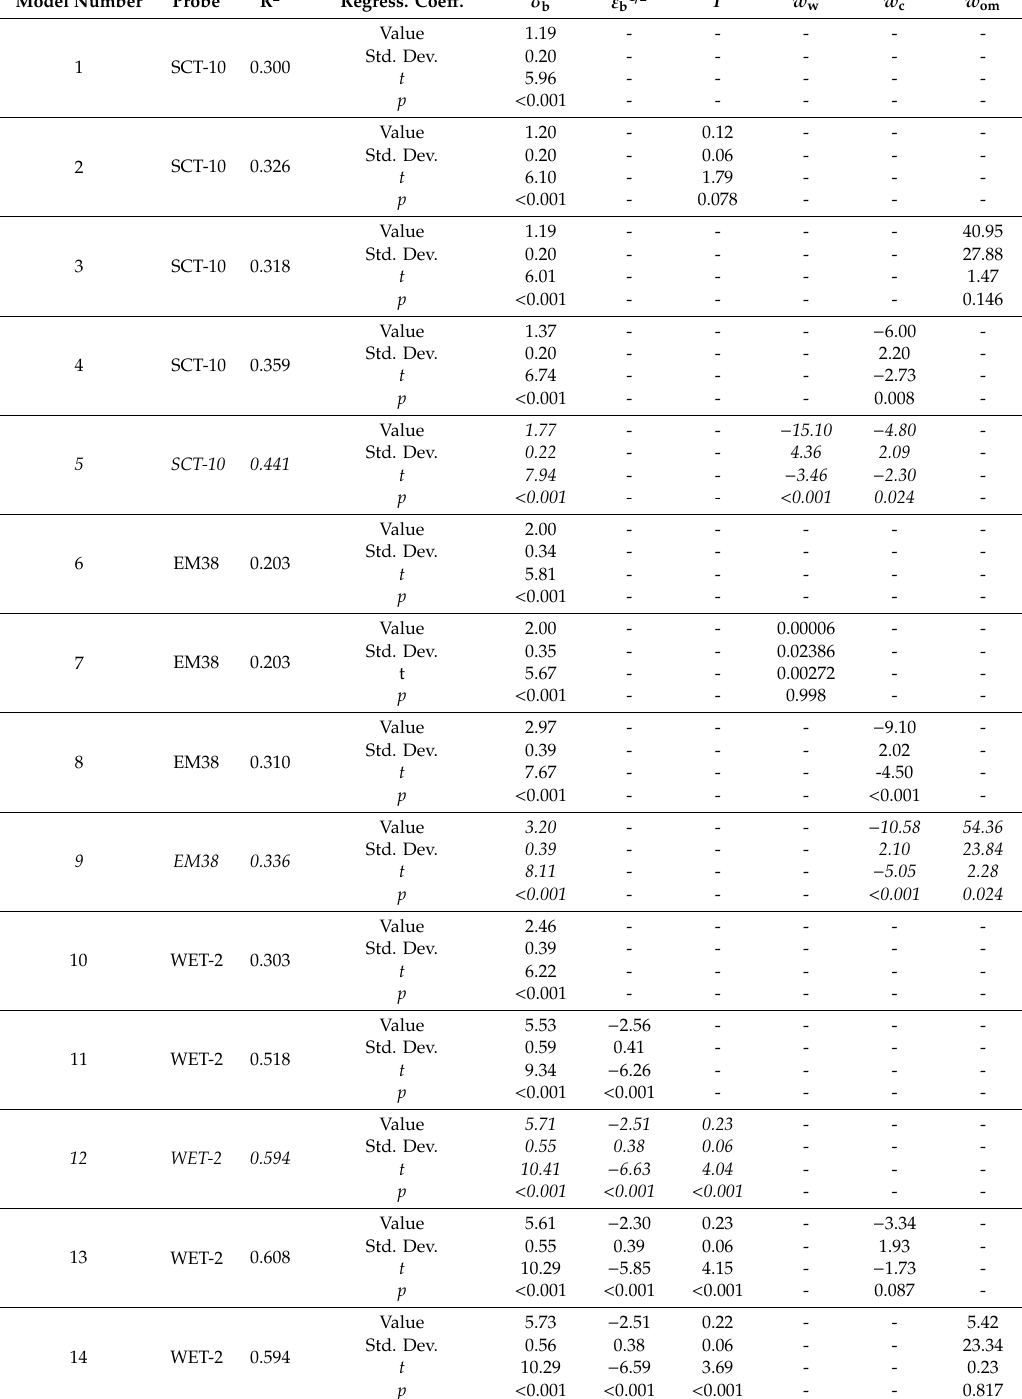
Table 8. Coe ffi cients of determination and regression along with their standard errors, student’s t and p values for the di ff erent multiple linear regression models developed to estimate the saturation extract electrical conductivity at 25 ◦ C ( σ e ), where the best most parsimonious model for each probe has been highlighted in